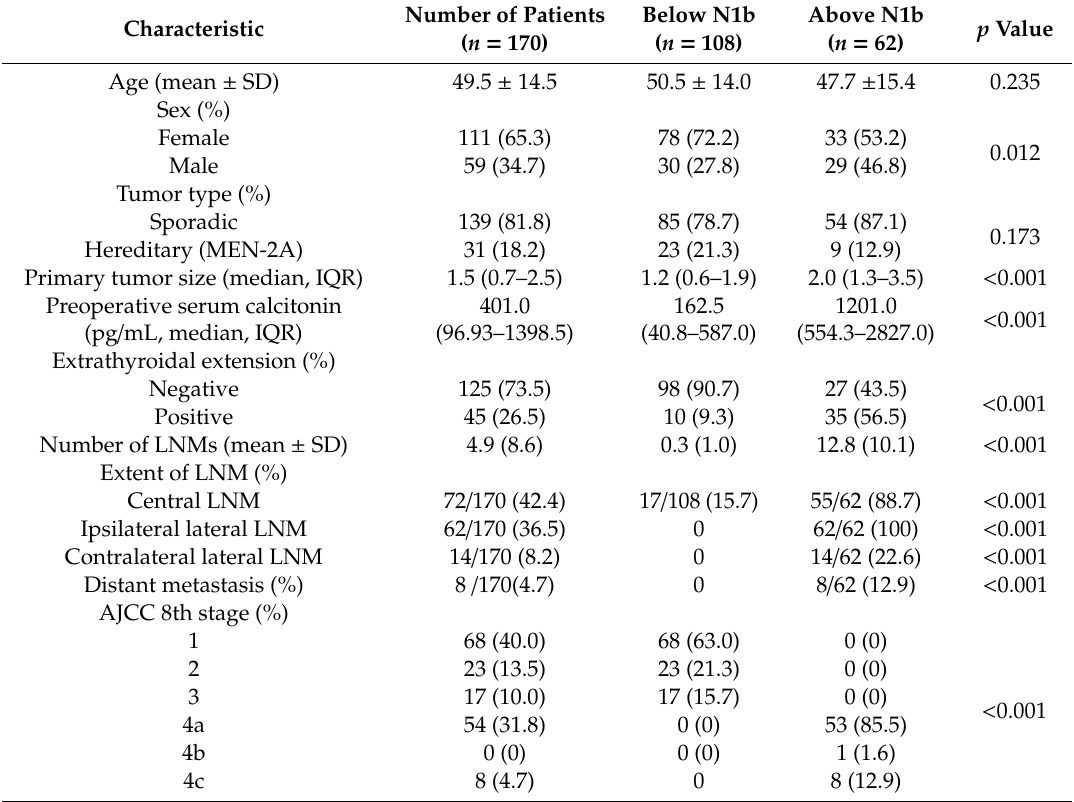
Table 1. Baseline clinicopathologic characteristics of the patients.